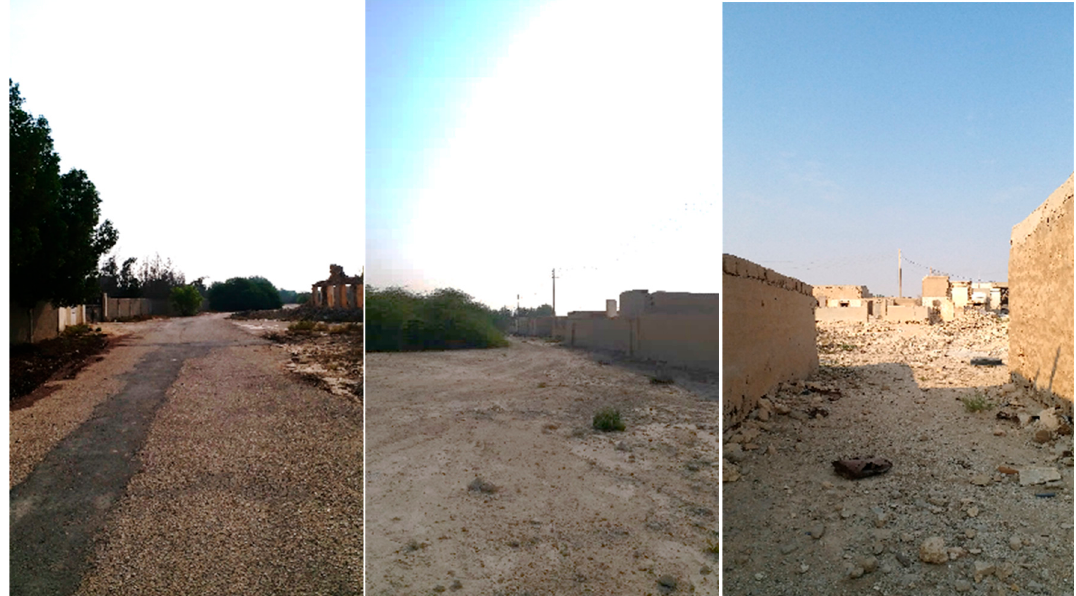
Figure 7. illustrates three examples of the hierarchy of the circulation network. It shows, from left to right, the ring road or the primary (Sikka), an inner road (sikkak) and a pathway (Dakhous).